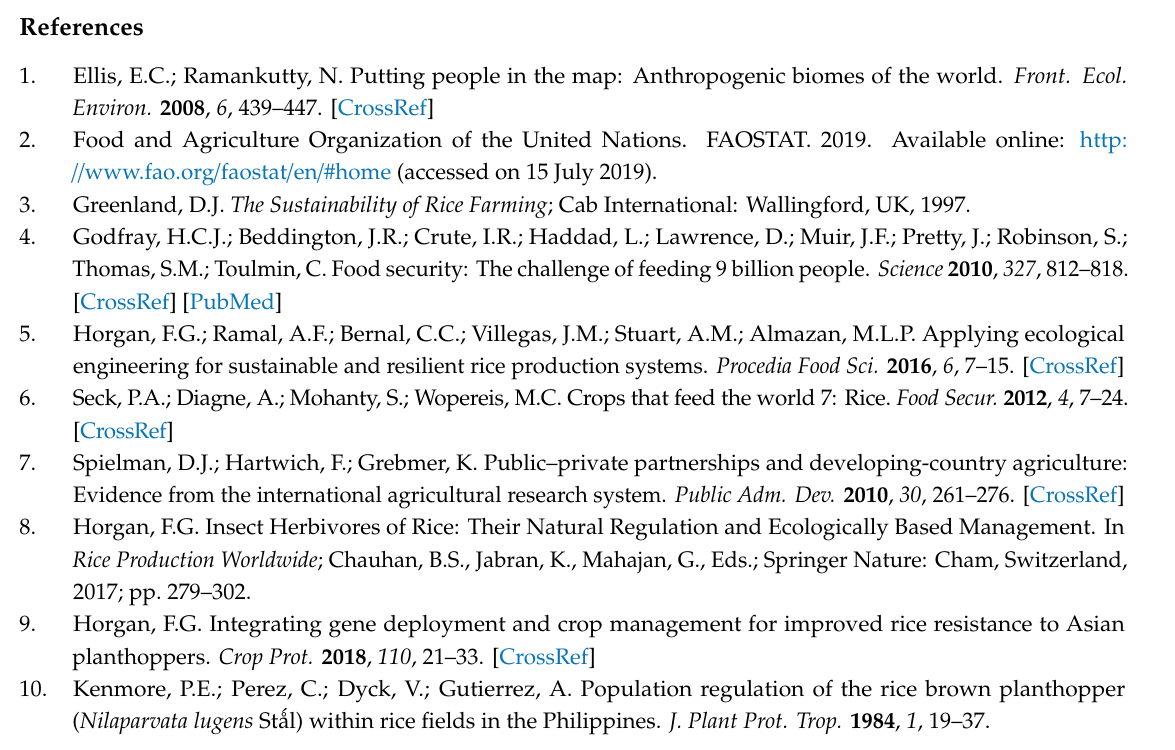
Figure S1: Relative abundance of the principal natural enemies of rice herbivores from sweepnet sampling of rice plots during July (J) and August (A) of 2011, Figure S2: Relative abundance of rice herbivores on clear bunds, weedy bunds, and sesame / okra bunds during